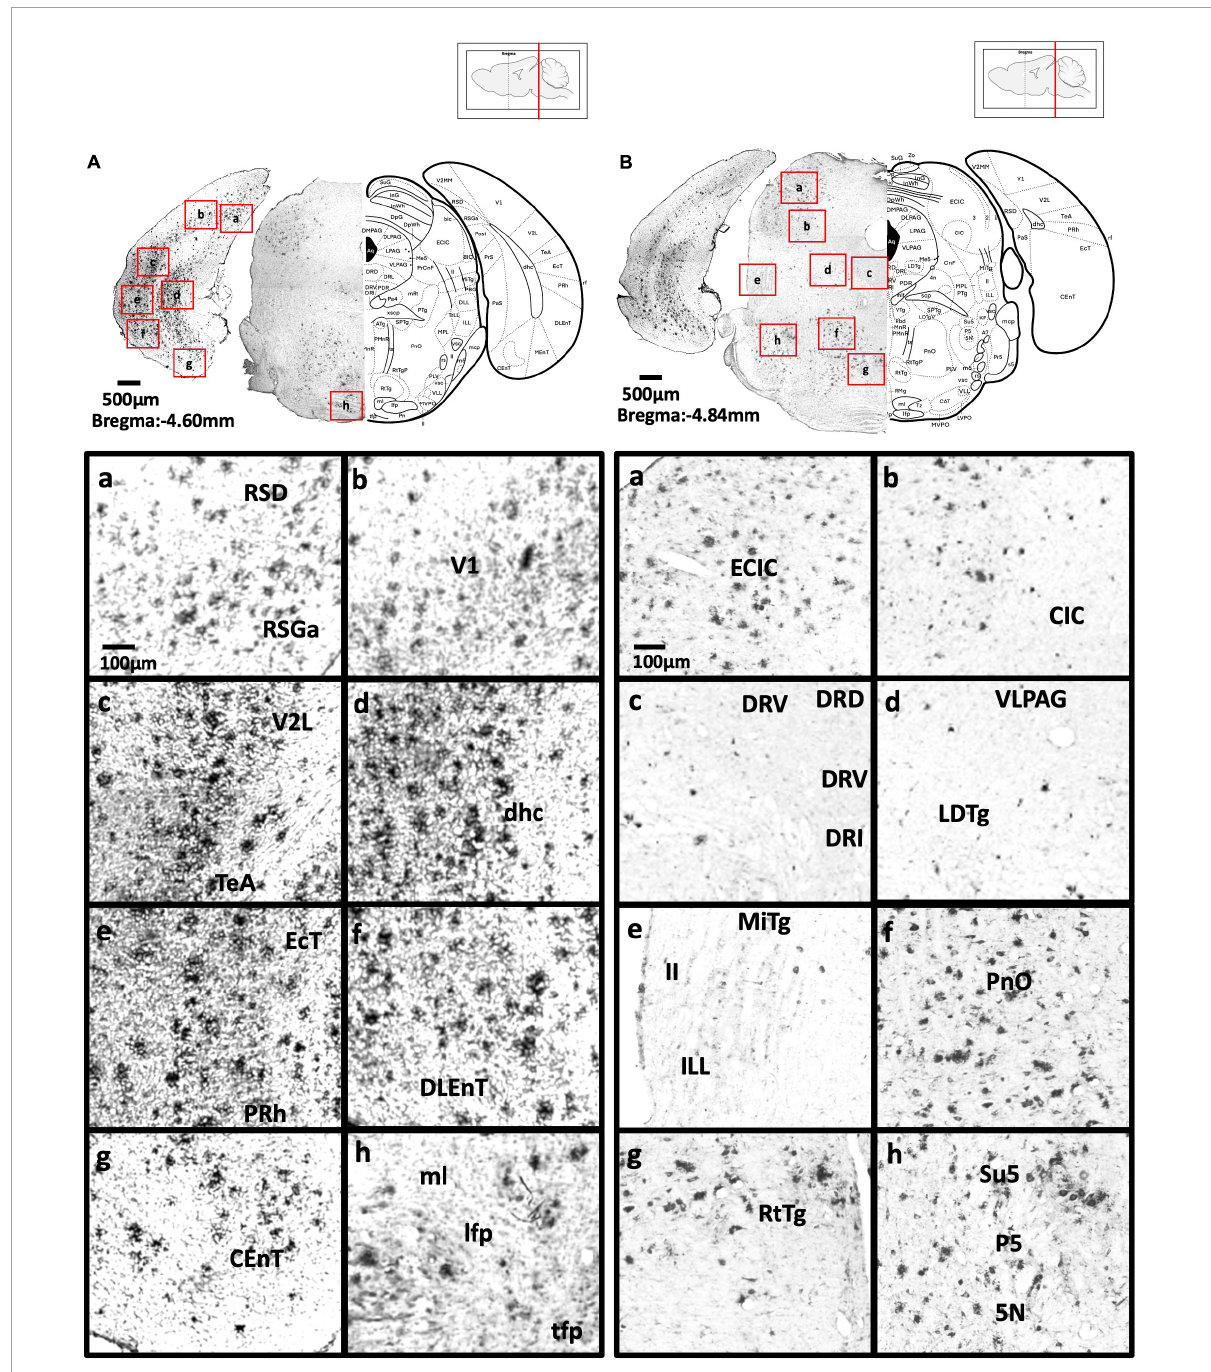
FIGURE7 (A) Coronal section through the midbrain showing A β deposition in the retrosplenial dysgranular cortex, A region of retrosplenial granular cortex (a), primary visual cortex (b), lateral secondary visual cortex (c), dorsal hippocampal commissure (d), ectorhinal cortex, perihinal cortex (e), dorsolateral entorhinal cortex (f), caudomedial entorhinal cortex (g), medial lemniscus, longitudinal fasciculus of nucleus, and transverse fibers of the pons (h). (B) Coronal section through the midbrain showing A β deposition in the external cortex of the inferior colliculus (a), central nucleus of the inferior colliculus (b), dorsal, ventral, interfascicular, and lateral dorsal raphe (c), ventrolateral periaqueductal gray, laterodorsal tegmental nucleus (d), microcellular tegmental nucleus, lateral lemniscus, intermediate nucleus of the lateral lemniscus (e), oral region of the pontine reticular nucleus (f), reticulotegmental nucleus of the pons (g), supratrigeminal nucleus, peritrigeminal zone, and motor trigeminal nucleus